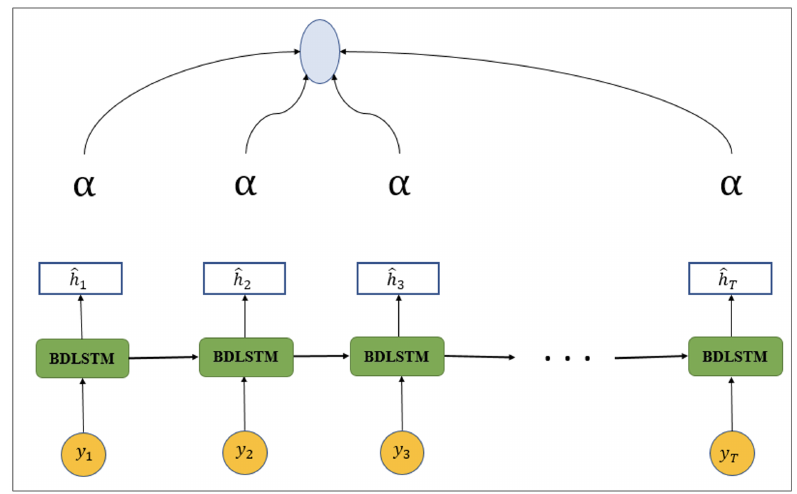
Figure 2. AttBDLSTM